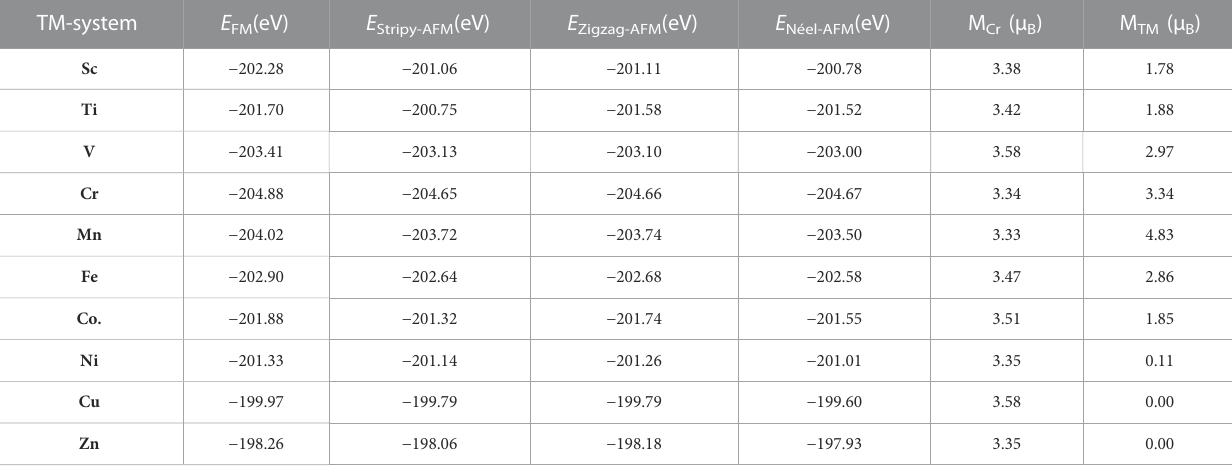
TABLE 1 The calculated total energy of the monolayer Cr 2 Ge 2 Te 6 absorbed the transition metals with four different magnetic con fi gurations, the magnetic moment of the Cr atom near the absorption site ( M Cr ), and the magnetic moment of transition metals in the monolayer Cr 2 Ge 2 Te 6 absorbed systems (M TM